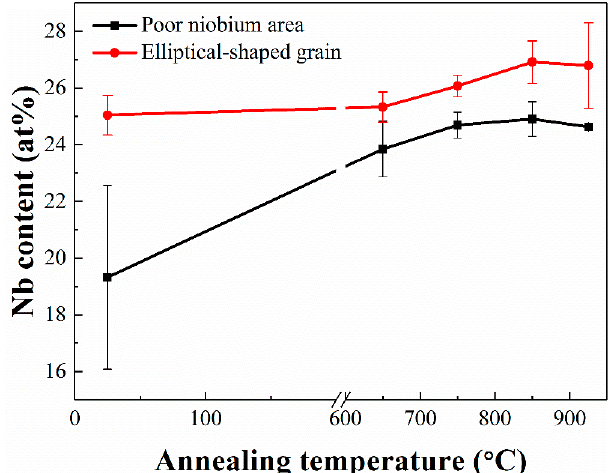
Figure 8. Comparison of Nb content in different regions of Ti–26Nb alloys after annealing at different temperatures.